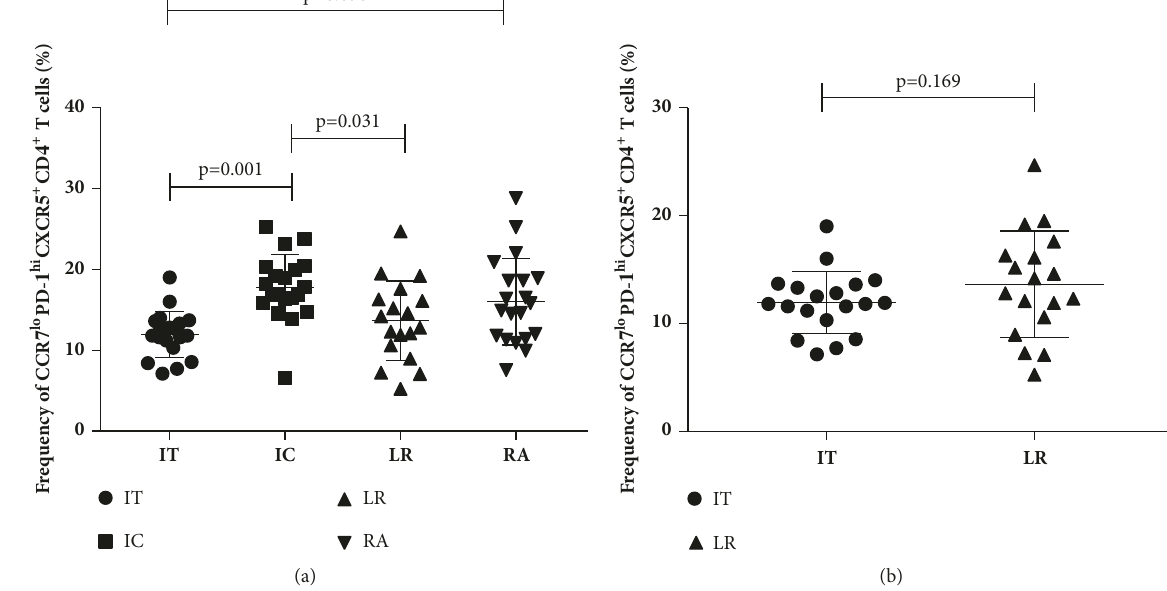
Figure 3: Frequency of CCR 7 lo PD- 1 hi CXCR5 + CD4 + T cells among all CXCR5 + CD4 + CD3 + cells in the patients with chronic HBV infection and between IT group and LR group. (a)Differences between the IT group (n=19) and IC group (n=20), between the IT group and RA group (n=20), and between the IC group and LR group (n=18) were significant. Statistical comparison was performed using a Bonferroni correction. (b)Difference between the IT group (n=19) and LR group (n=18) was not significant (p=0.169). The horizontal lines show the